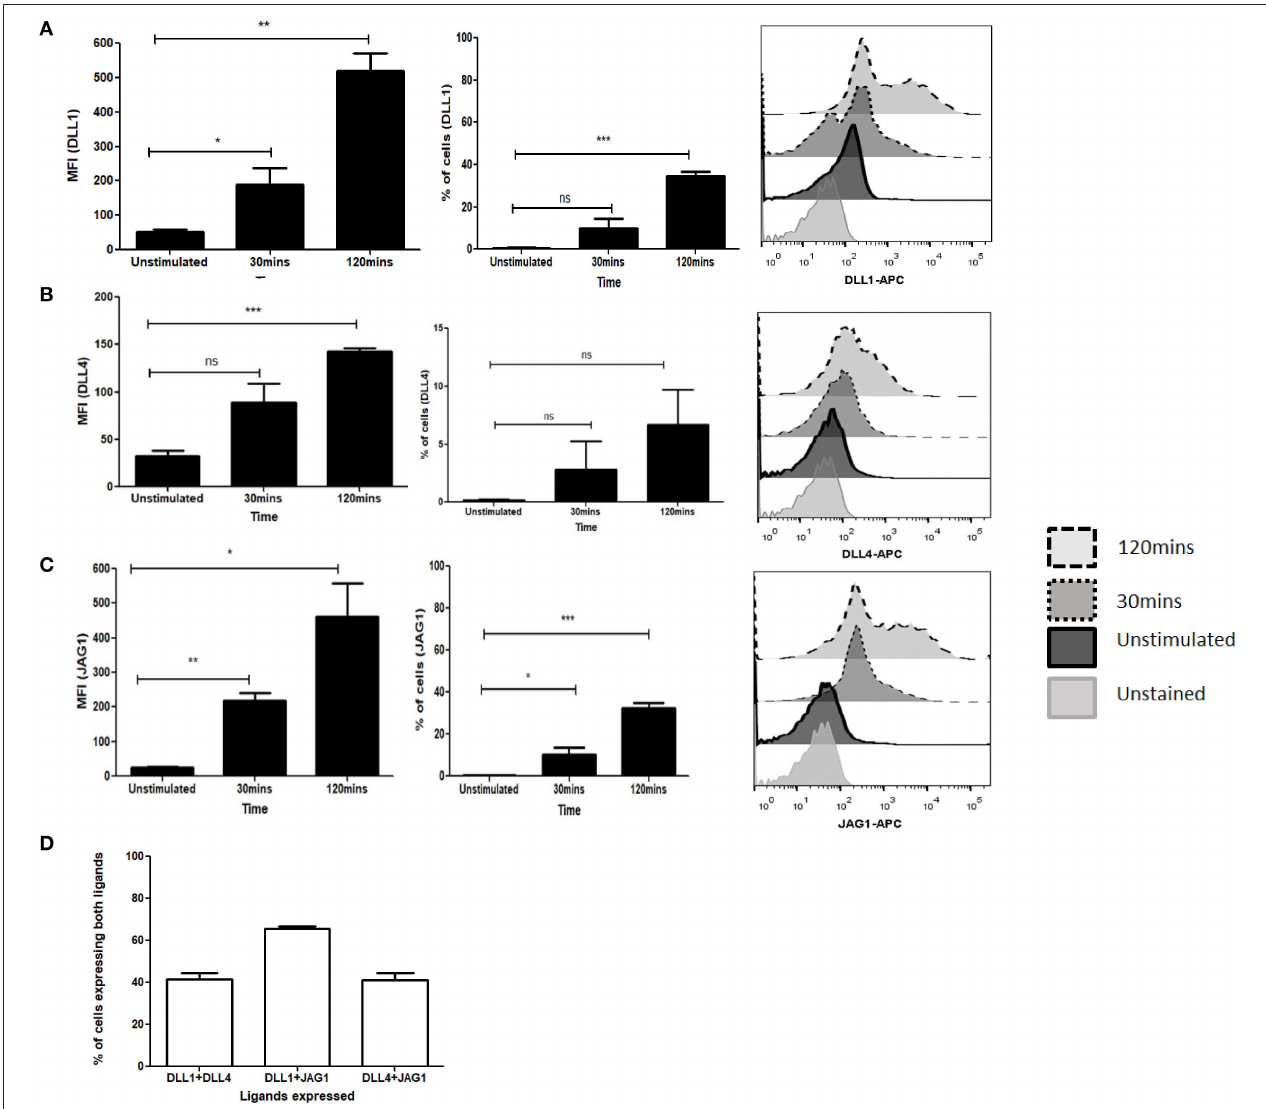
FIGURE 1 | Activation of T cells induces expression of Notch ligands. CD4T cells from C57BL/6 mice were treated with soluble anti-CD3 ε and anti-CD28 at 1 µ g/mL each for indicated time points. Cells were harvested and analyzed by flow cytometry by gating on live cell population as determined by absence of Zombie staining. MFI and percentage of ligand positive cells were plotted values were plotted for (A) DLL1, (B) DLL4, and (C) JAG1. Histograms to the right of (A–C) show expression of DLL1, DLL4, and JAG1 at each time point. (D) Percentage of cells showing co-expression of ligands on CD4T cells. CD4T cells from C57BL/6 mice were treated with soluble anti-CD3 ε and anti-CD28 at 1 µ g/mL each for 6h and stained for antibodies against DLL1 and DLL4, or DLL1 and JAG1, or DLL4 and JAG1. Data represent three independent experiments. Data represent mean ± SEM. * p < 0.05, ** p < 0.005, and *** p < 0.001. ns, not